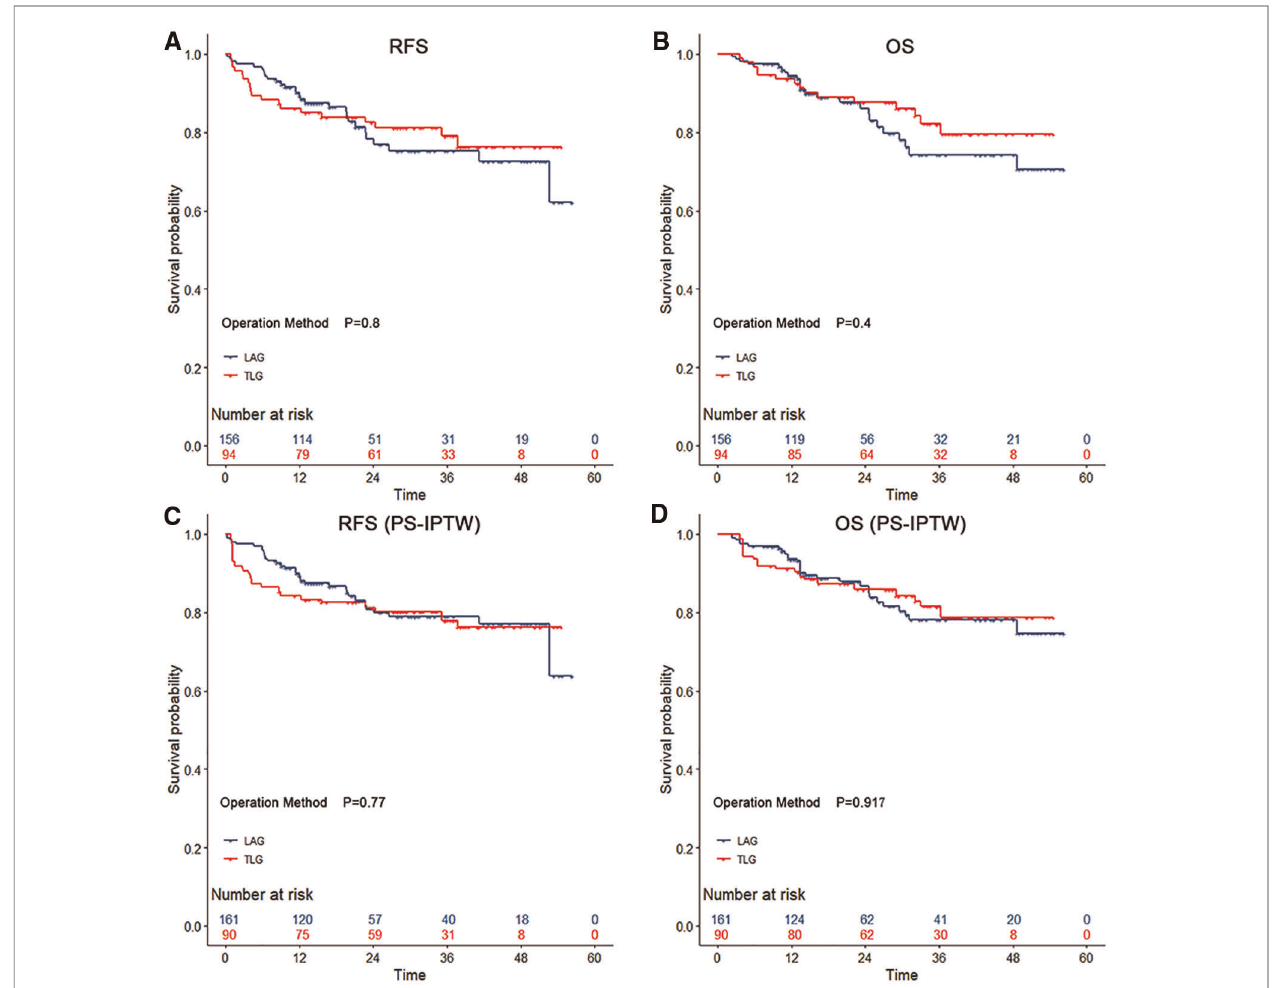
FIGURE 1 | The survival curves among gastric cancer with operation methods during the propensity score-based inverse probability of treatment weighting. According to the type of surgery, both totally laparoscopic gastrectomy and laparoscopic-assisted gastrectomy showed no signi fi cant differencess in relapse-free survival and overall survival ( p >0.05 by the log-rank test). The risk tables show the actual number of patients with operation